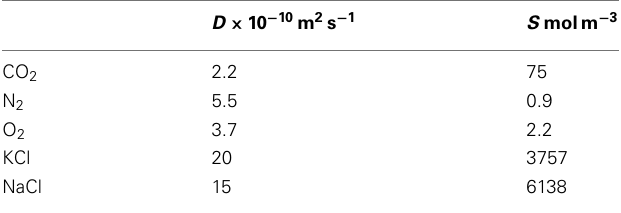
Table 1 | Diffusivities ( D ) and solubilities ( S ) of typical solutes in xylem